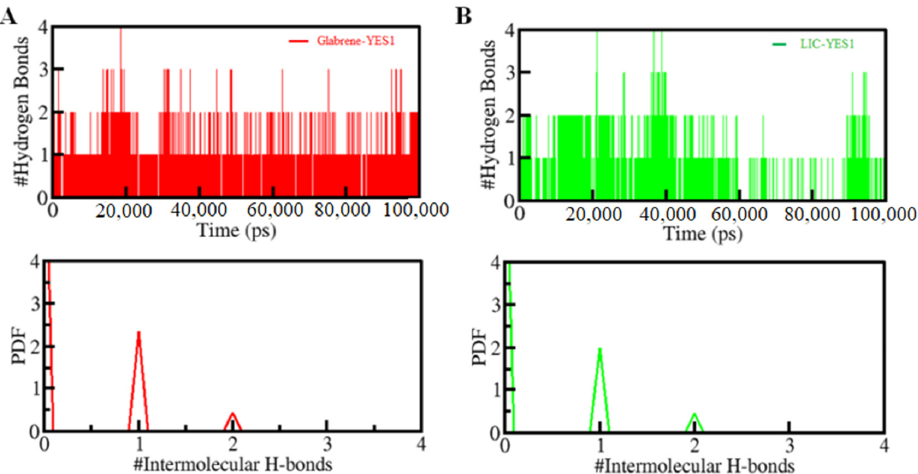
Figure 6. Time-evolution of intermolecular H-bonds formed within 0.35 nm between YES1 and ( A ) Glabrene and ( B ) LIC. The lower panels show the PDF of the hydrogen bond distribution. # represents number.